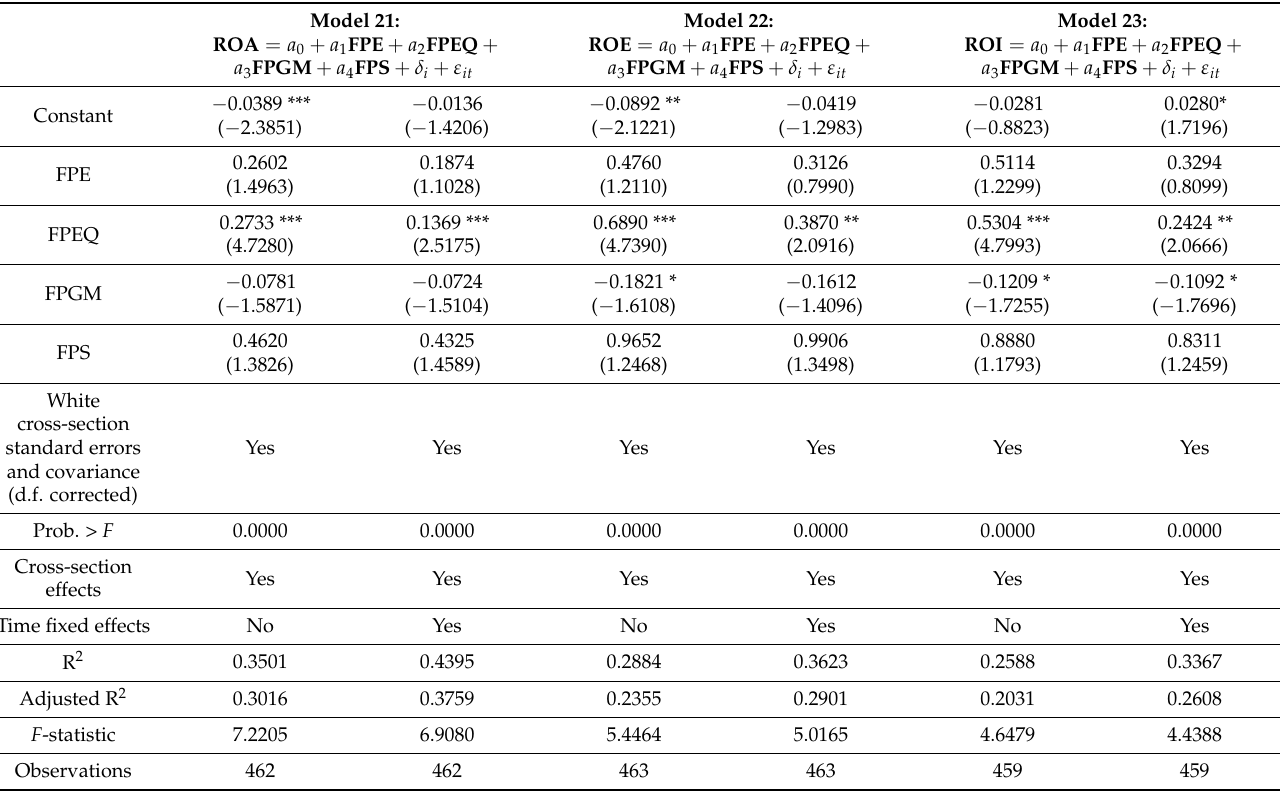
Table 12. Econometric models for gas